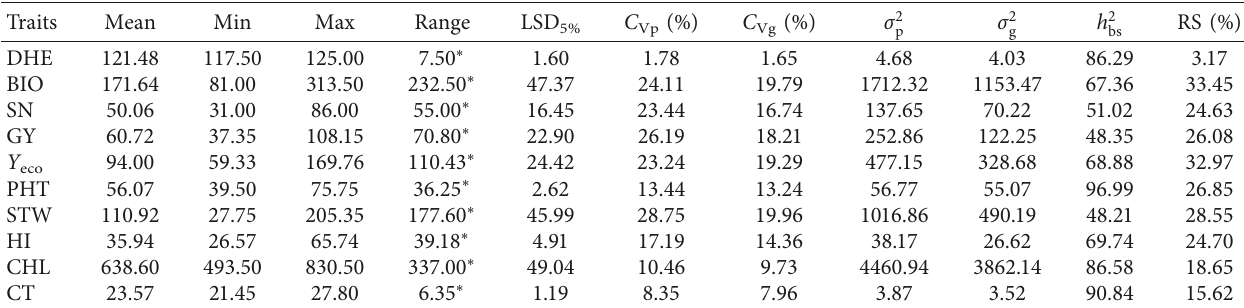
Table 4: Arithmetic mean, minimum and maximum values, range, least significant difference, phenotypic and genotypic coefficients of variation, phenotypic and genotypic variances, broad-sense heritability, and expected response to selection for 10 morphological and agronomic traits of 56 durum wheat genotypes evaluated in 2014-2015.